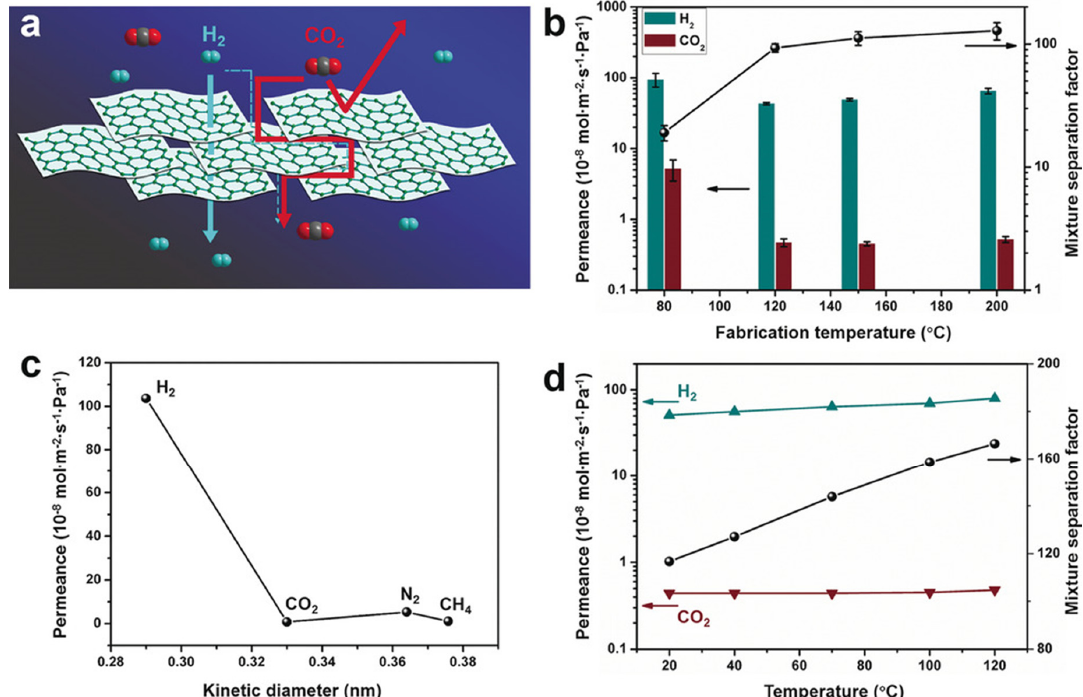
Figure 24. ( a ) Illustration of the hypothesis of gas separation through porous Zn 2 (Bim) 3 nanosheets. Only Zn atoms are shown for clarity, and the light blue planes represent the nanosheets regardless of their amphiprotic natures. The solid and dashed lines represent the pathways of H 2 (blue) and CO 2 (red). ( b ) Binary gas separation performance of equimolar H 2 /CO 2 through the Zn 2 (Bim) 3 nanosheet membranes prepared at different temperatures via the hot-drop coating method. ( c ) Single gas permeation through a Zn 2 (Bim) 3 nanosheet membrane prepared at 200 °C. ( d ) Effect of varying